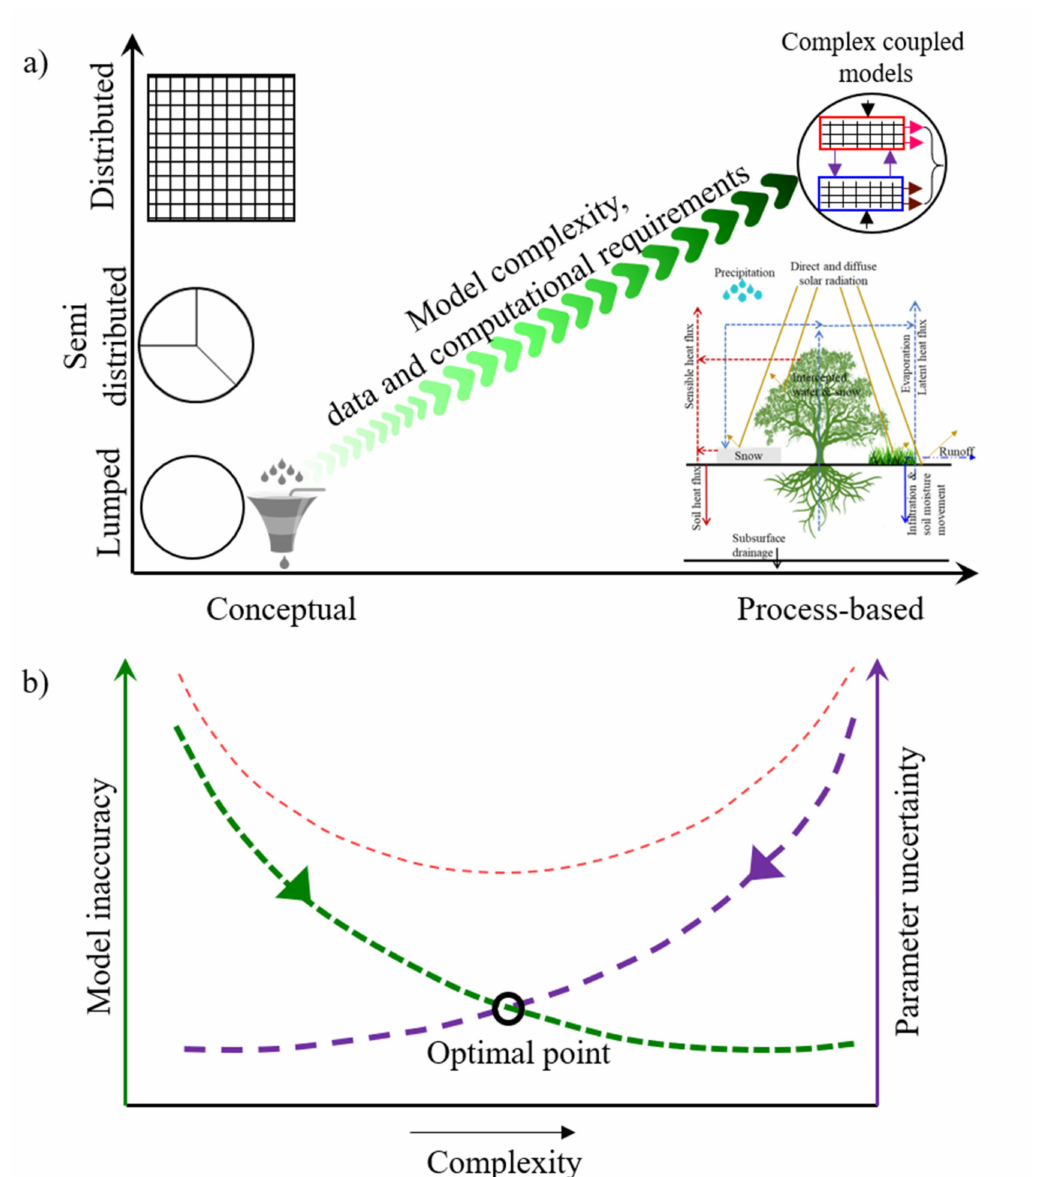
Figure 4. ( a ) The span of model complexity with respect to spatial resolutions and process complexity, ( b ) The bias–variance tradeoff curve relating model complexity and uncertainty. The green curve indicates the decrease in bias (model inaccuracy) as model complexity increases while the purple curve indicates a decrease in variance (parameter uncertainty) because of a decrease in model complexity. The red curve indicates the net effect of bias and variance. Both hydrological and statistical approaches are used to evaluate model